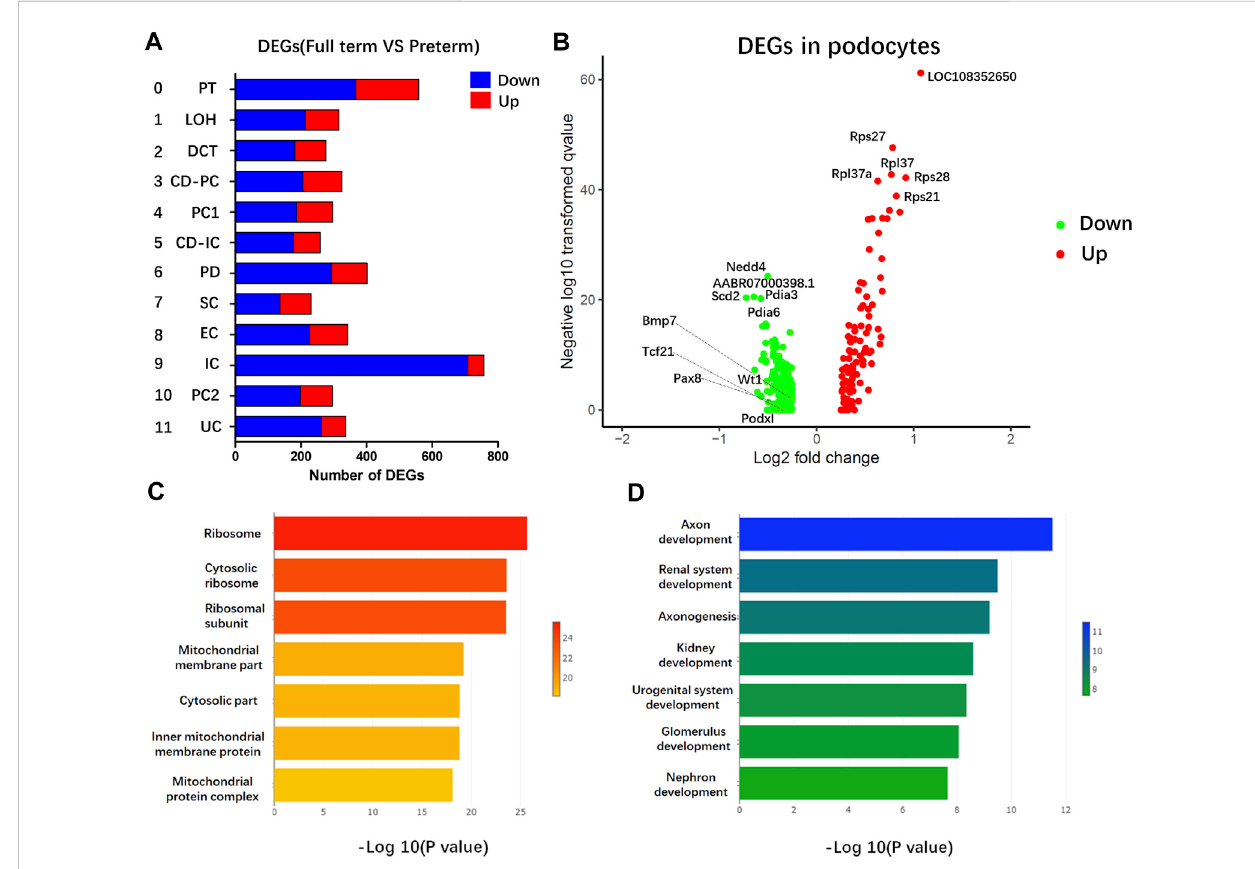
FIGURE 4 Gene expression comparison between full-term (postnatal day 0) and preterm kidneys (postnatal day 2). (A) Comparison between full-term and preterm kidneys according to cluster. The x-axis represents differentially expressed gene (DEG) counts between full-term and preterm kidneys. Downregulatedgenesareshowninblue;upregulatedgenesareshowninred.They-axisrepresentsdifferentcelltypes. (B) VolcanoplotshowingDEGsin PDs. In PDs from full-term rats, downregulated genes are shown in green, and upregulated genes are shown in red. (C,D) GO analysis of enriched genes in PDs from full-term rats (C) and enriched genes in PDs from preterm rats (D) . In PDs from full-term rats, most functional terms are related to ribosomes. In PDs from preterm rats, most functional terms are related to kidney